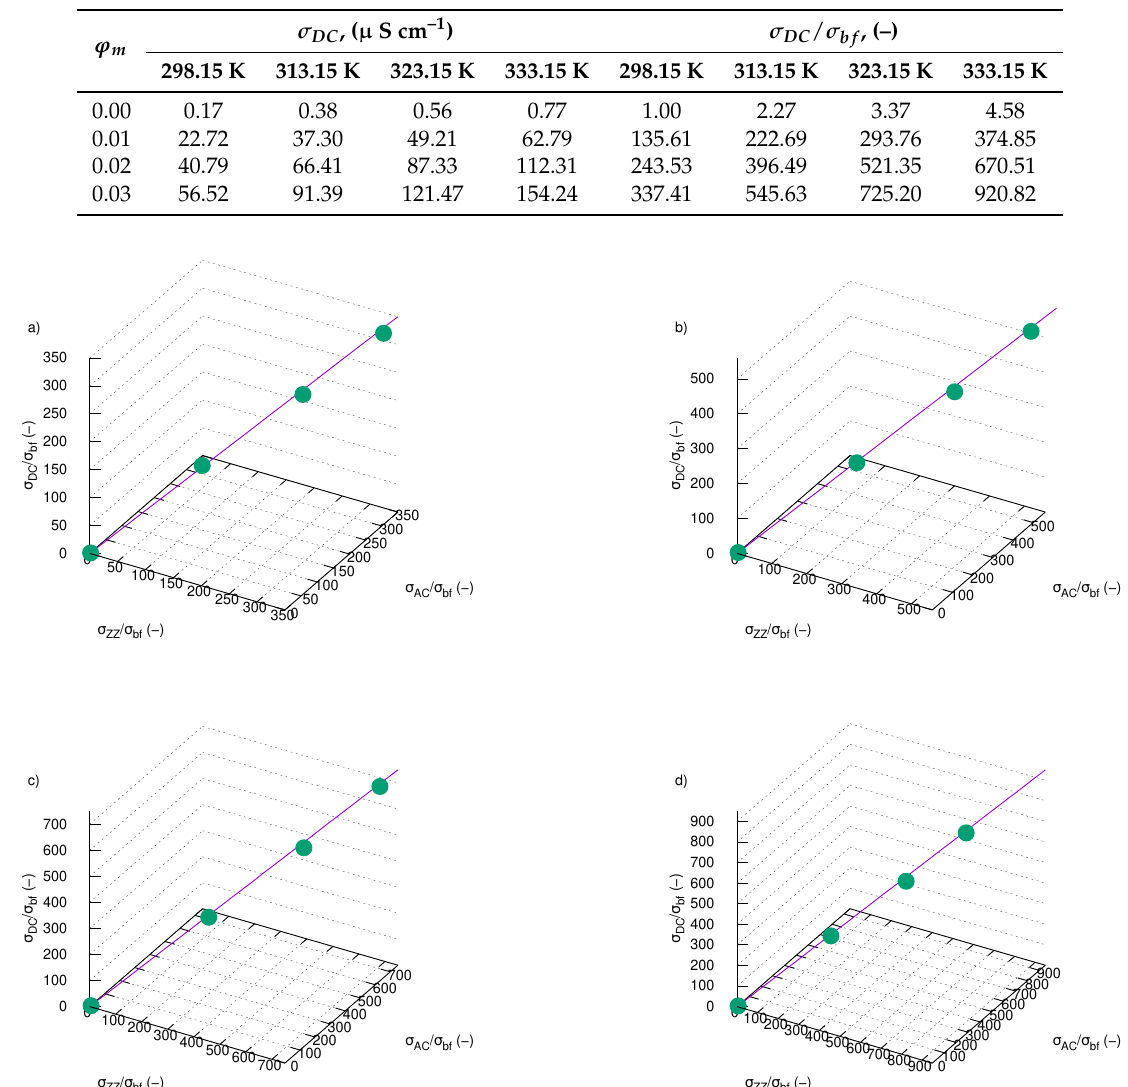
Table 4. Electrical conductivity, σ DC , of silicon oxide lignin ethylene glycol nanofluids for various temperature and mass fraction measured directly.